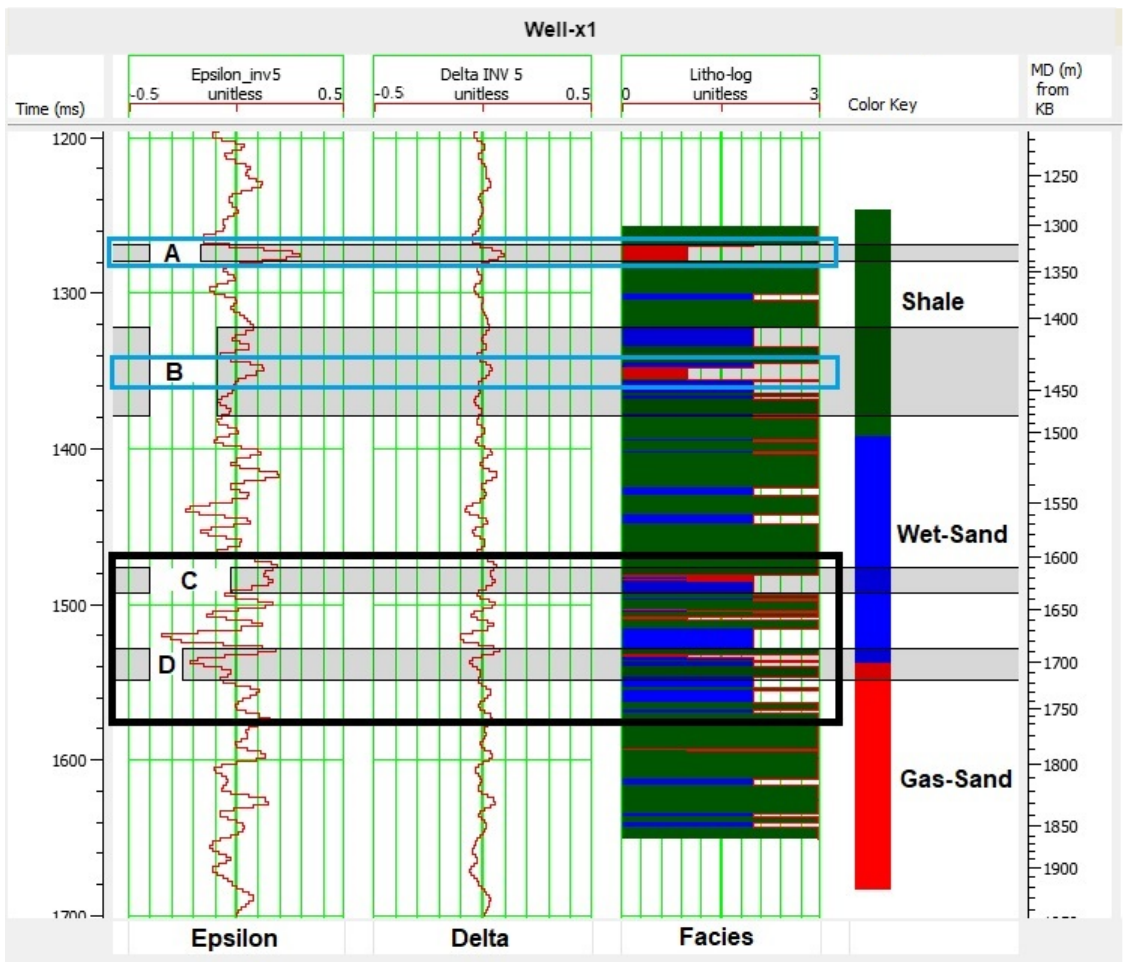
Figure 23. The anisotropy parameters, Epsilon and Delta, against the facies log at the well ( × 1), where A, B, C, and D are sand